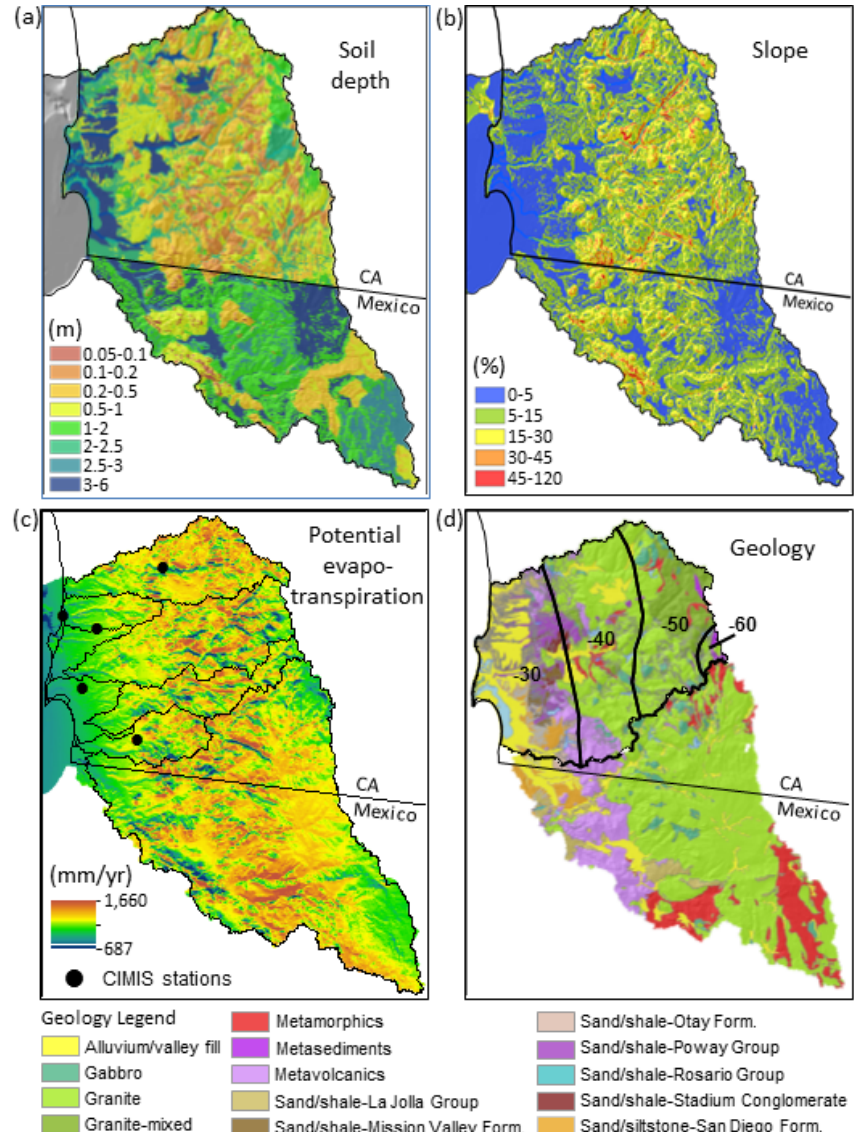
Fig. 3. Input maps for the Basin Characterization Model in the San Diego region study area illustrating (a) soil depth, (b) slope, (c) average annual potential evapotranspiration, and (d) geology and isotopic zones, as δ deuterium